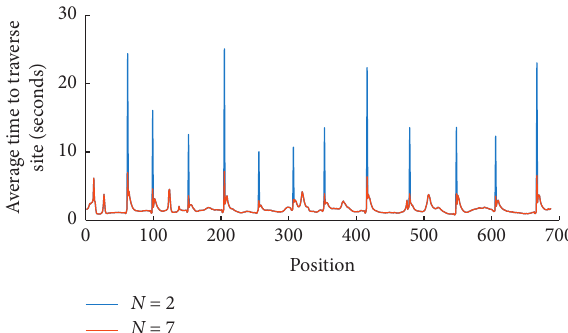
Figure 6: The average time the bus takes to traverse each site of the route based on the number of active buses. The total time taken for a bus to reach its destination position can be derived by taking the total area under the curve between the two points.